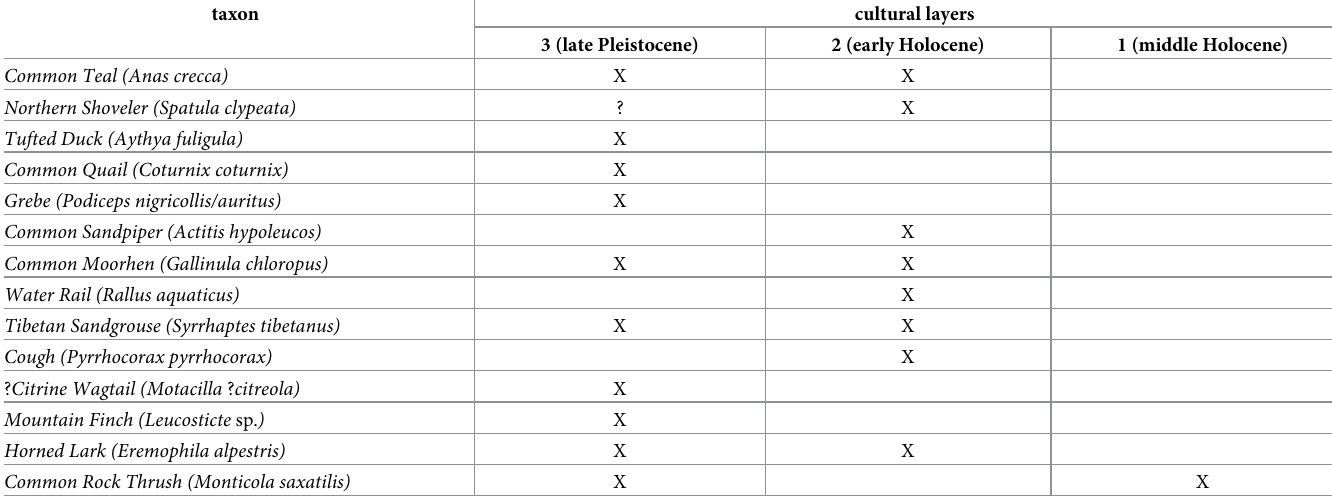
Table 2. Occurrence of various bird taxa in different layers of Istykskaya cave. taxon cultural